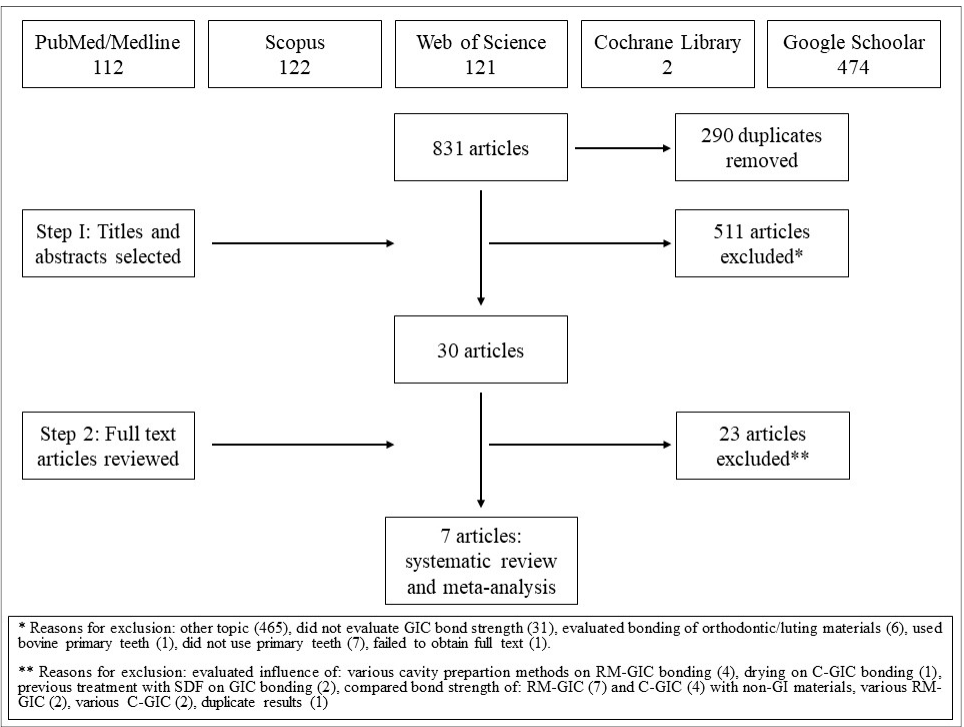
Figure 1. Flow chart of study selection.